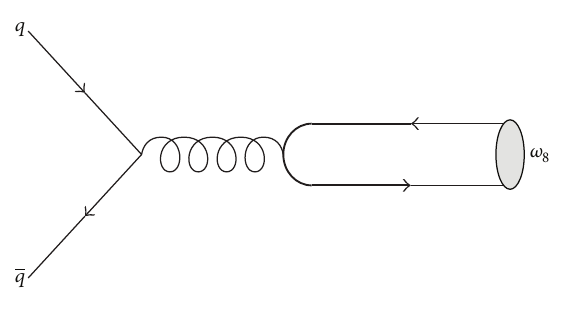
Figure 4: Production mechanism for the color-octet, isoscalar- vector meson 𝜔 8 at hadron